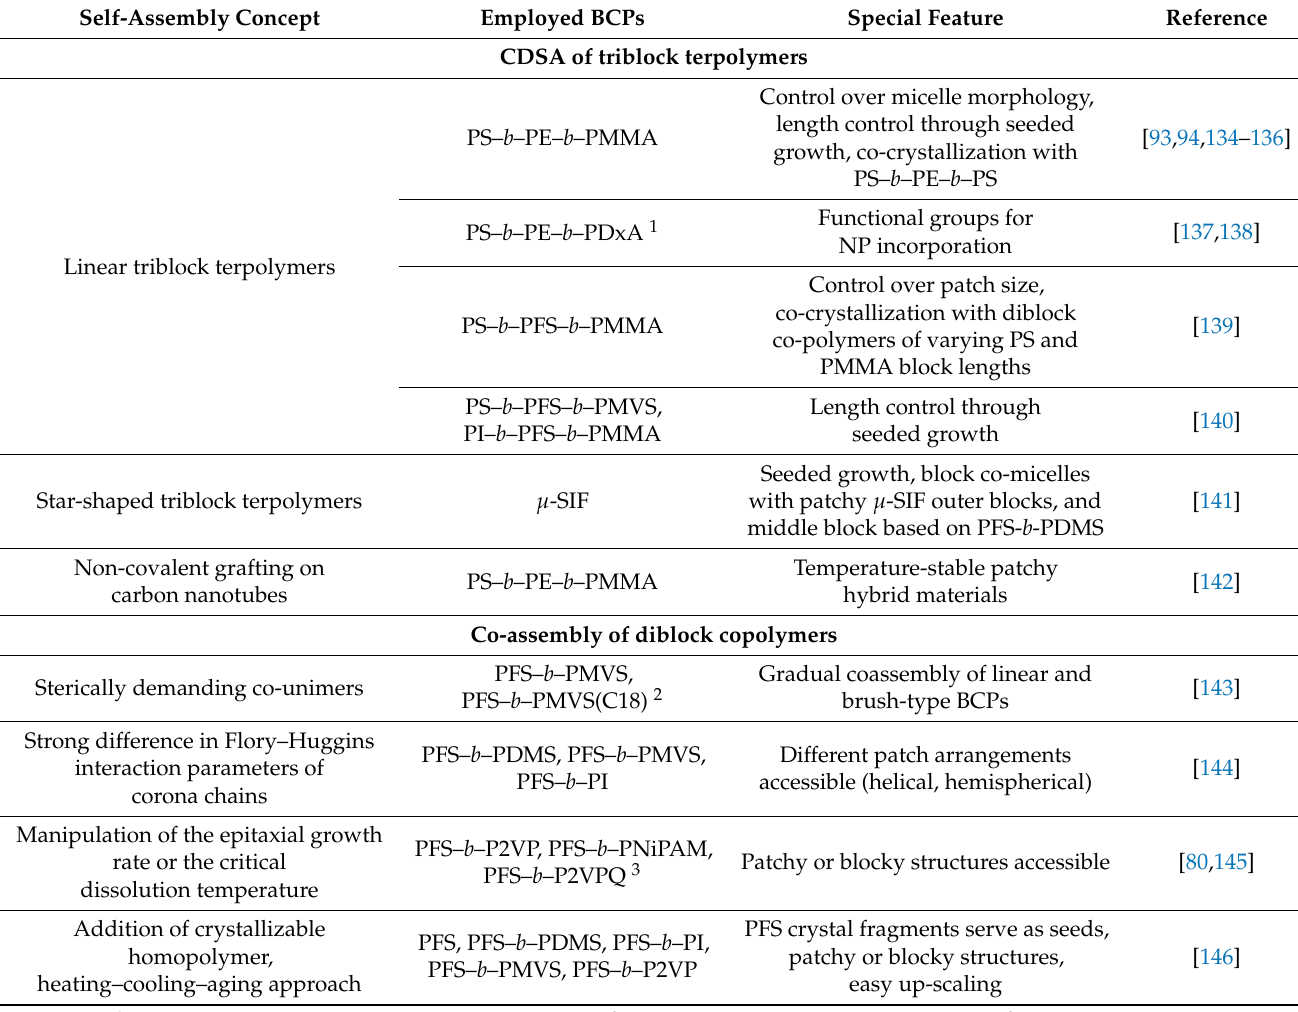
Table 1. Overview of self-assembly concepts for patchy micelles with a crystalline